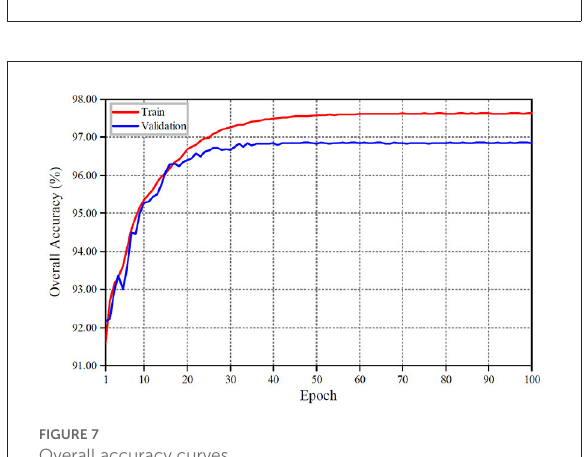
FIGURE7 Overall accuracy